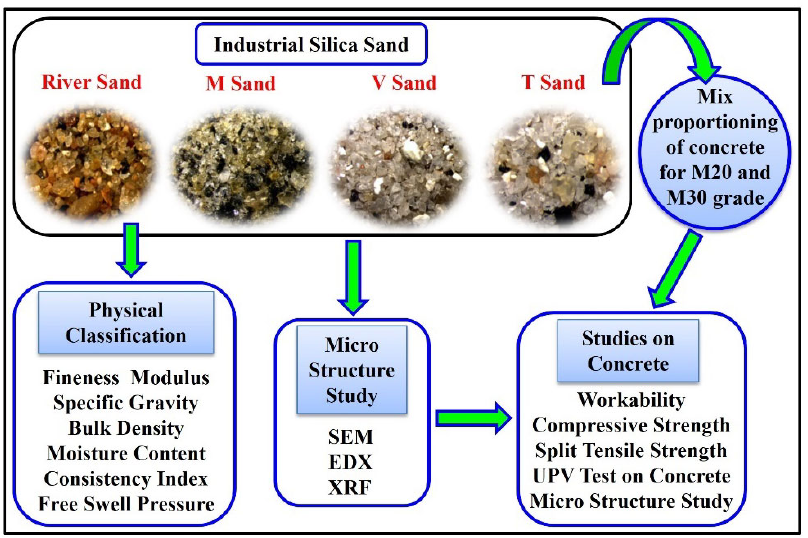
Figure 1. Investigation frame work.